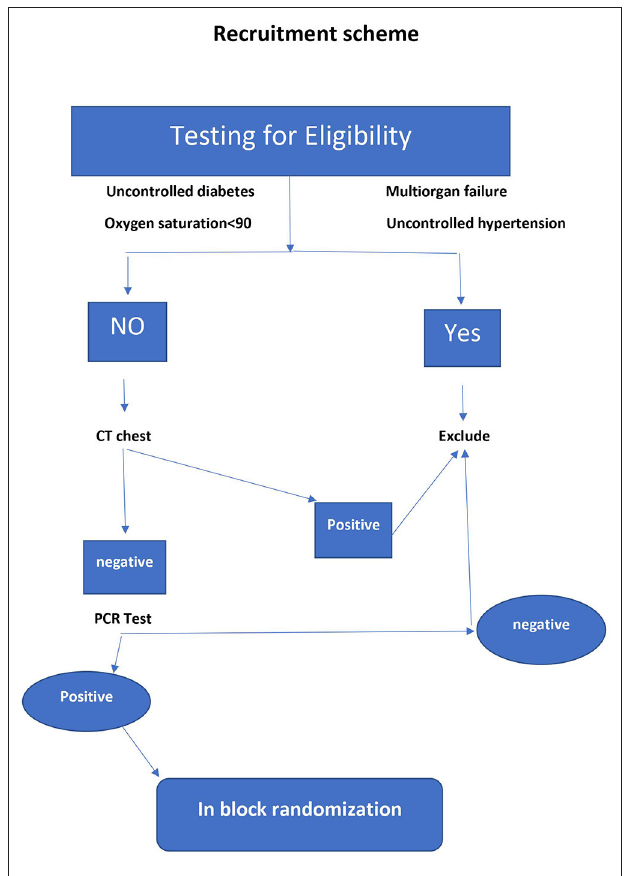
FIGURE 2 | Recruitment scheme.